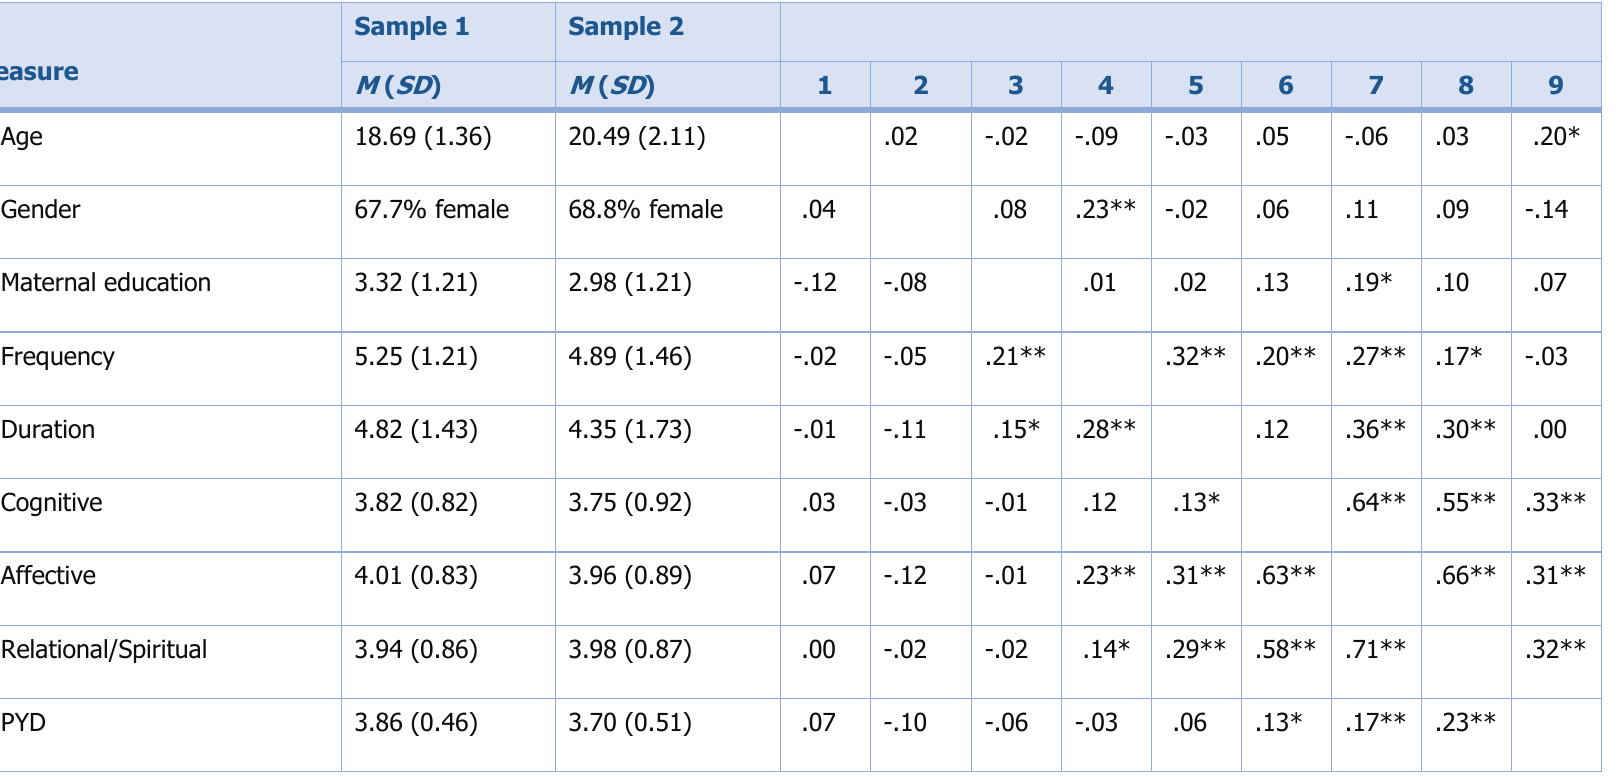
Table 1. Summary of Means, Standard Deviations, and Zero-Order